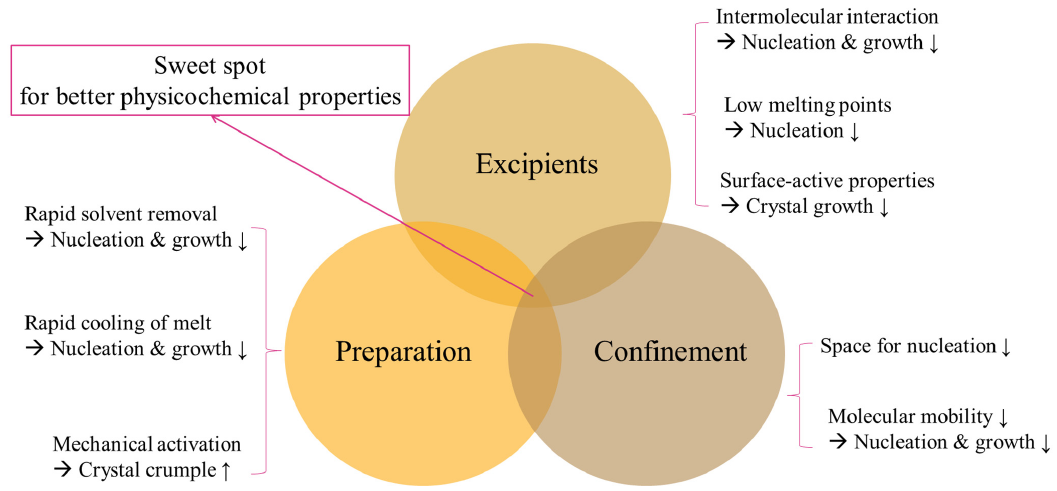
Figure 6. Formulation conditions affecting